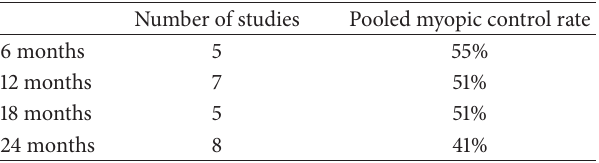
Table 6: Subgroup analyses of pooled myopic control rate of different treatment duration.